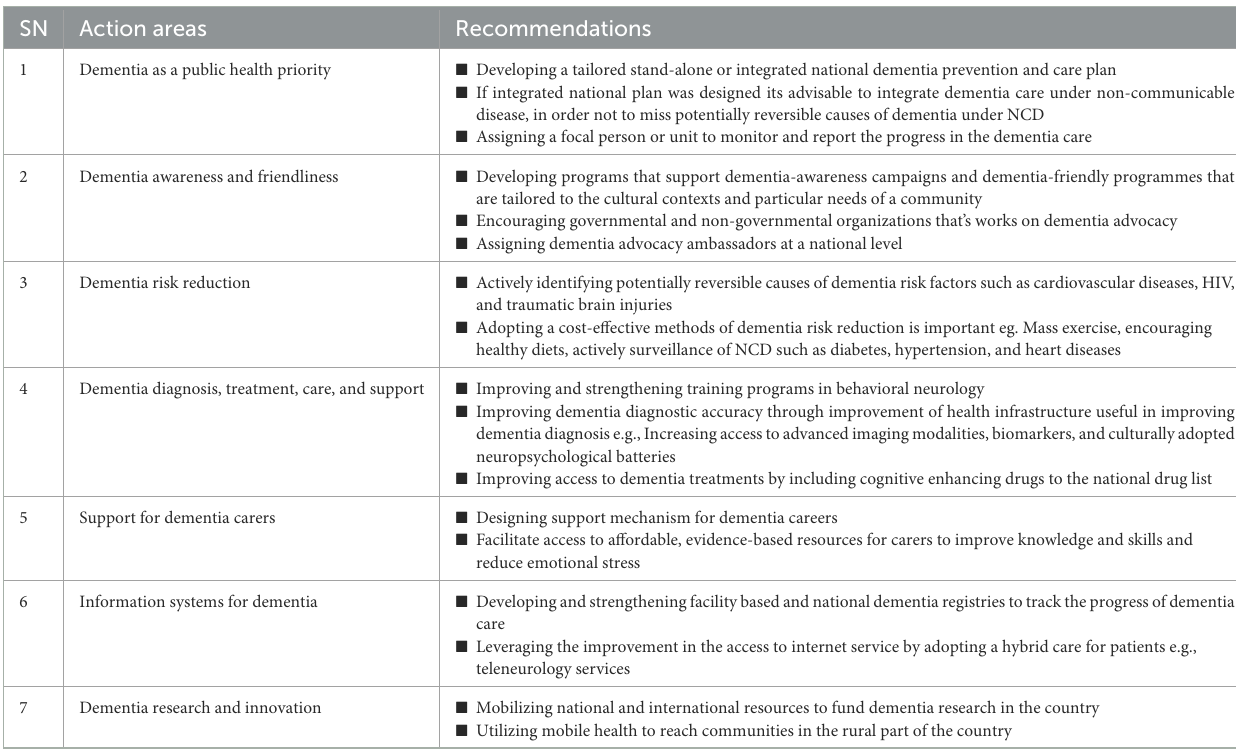
TABLE 1 Summary of recommendations based on the WHO global action plan (8).